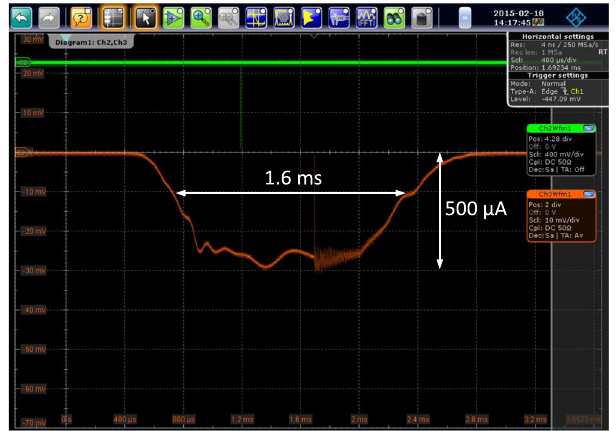
FIG. 17. The 1.6 ms and 500 μ A beam current measured by oscilloscope.